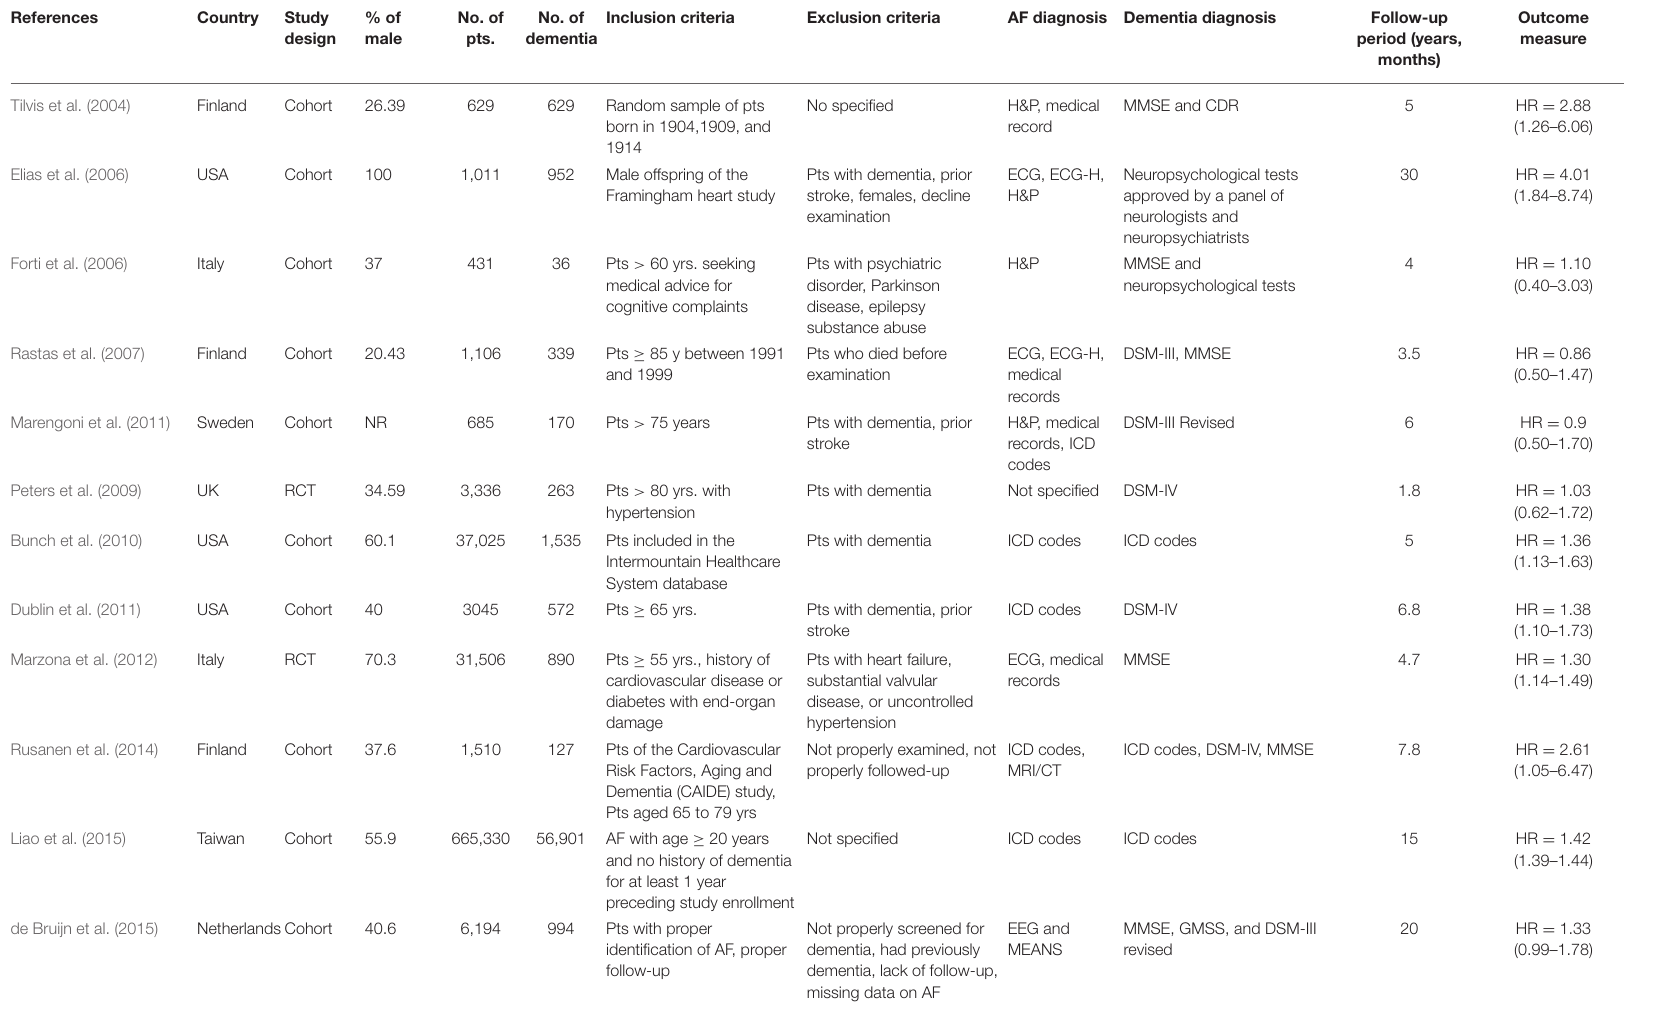
TABLE 1 | Characteristics of included